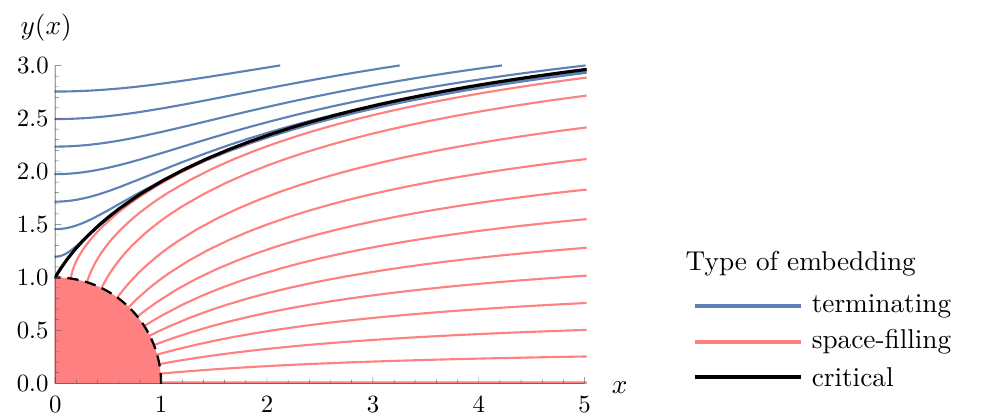
Figure 2. Numerical solutions of the equation of motion (4.32) for the embedding y ( x ) in the Cartesian coordinates for α = 1 / 2 or R 0 = 1 . Terminating embeddings are in blue (top curves) while space-filling embeddings in pink (bottom curves) and there is a critical embedding in black separating the two. The massless solution y ( x ) = 0 is also drawn at the bottom of the plot. The pink shaded region x 2 + y 2 < R 2 is not covered by the coordinates and the circle x 2 + y 2 = R 2 0 corresponds to the tip u = c of Euclidean AdS 4